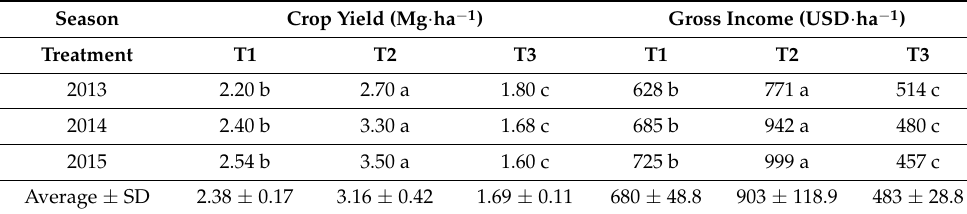
Table 6. Sunflower yield and gross income (price of crop × crop yield) for the three treatments in the three growing seasons. The price of the crop was taken to be 285.5 USD · Mg − 1 , which equated to the 3-year average (2012–2014) perceived by the grower. Different letters (between treatments and within the same year) indicate that mean values are significantly different at a 95% confidence interval. Treatments were Tc + DDO (T1), Rc + Tc + DDO (T2), and no Tc + DDO (T3), where Tc is turbo coulter blade, Rc is row cleaner, and DDO is double-disc opener. Crop Yield (Mg · ha − 1 ) Gross Income (USD · ha − 1